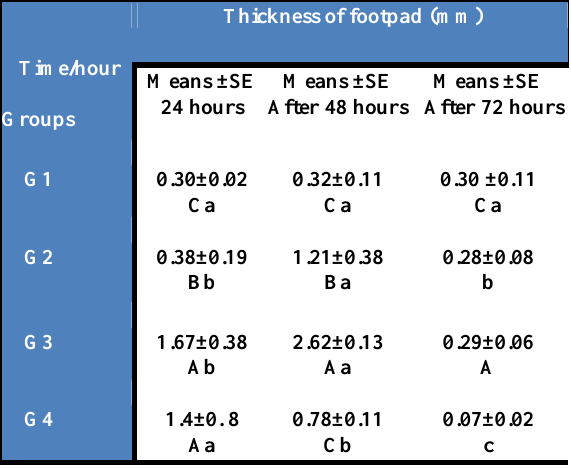
Table, 1: The Mean ± SD mm thickness of footpad in groups (G1, G2, G3 and G4) at day 21 after inoculation with different concentration of SEBA.